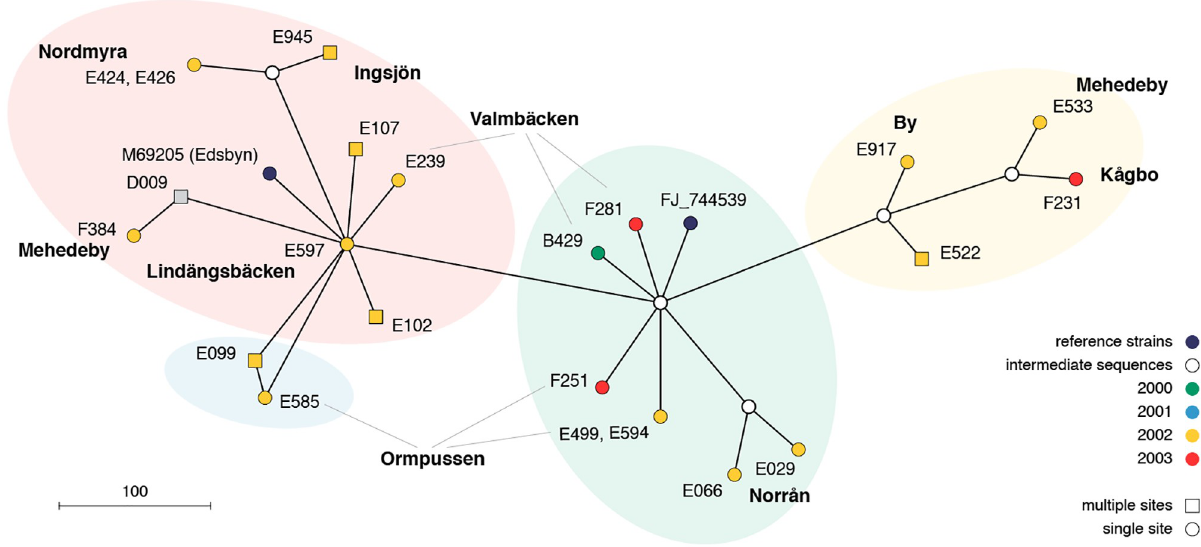
Fig 7. Median joining network analysis of partial sequences of Sindbis virus strains from the River Dala¨lven floodplains in central Sweden.